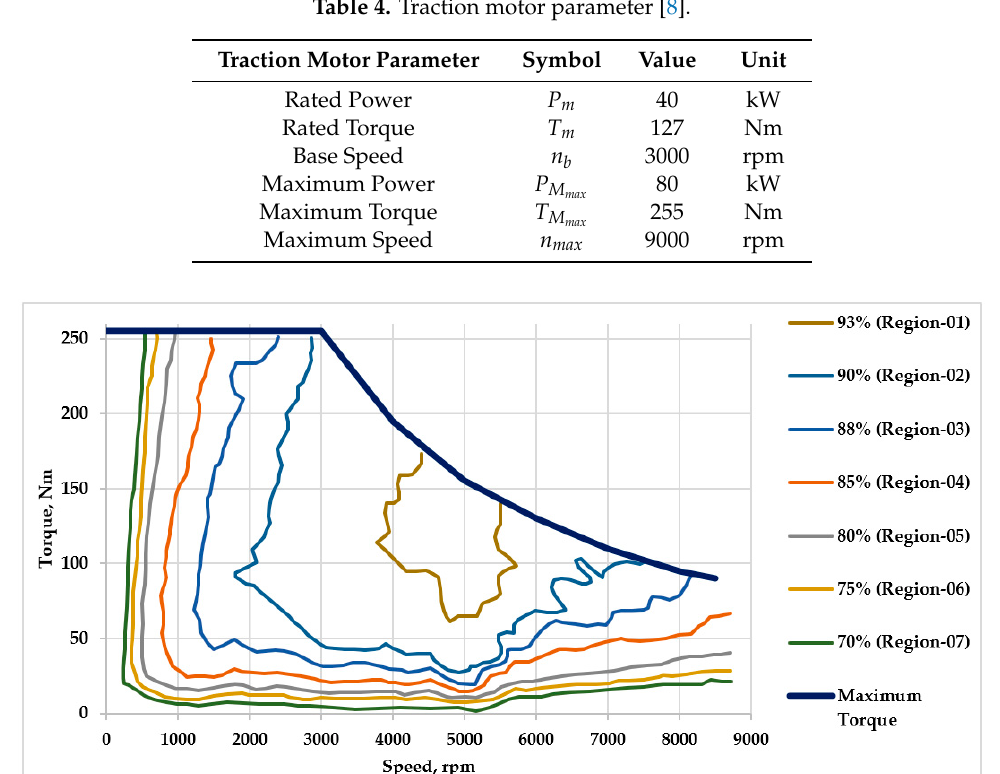
ffi ciency maps of the motor